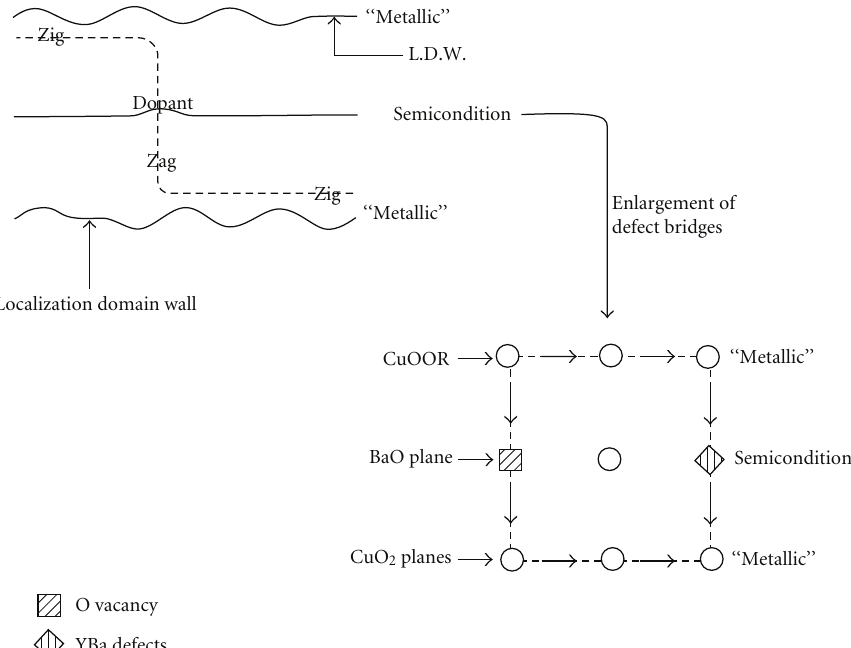
Figure 4: The original ZZIP model, reprinted from [35]. Parts of the original ZZIP path are now labeled “zig” or “zag.” In 1989 it was not clear what the interlayer dopants were and they were simply called defects, but it is now clear that they are usually interstitial oxygen atoms, except in La 2 − x Sr x CuO 4 , where they are the substitutional Sr